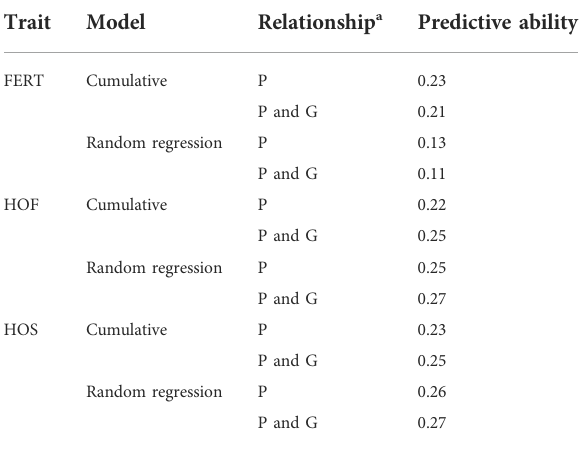
TABLE 11 Estimates of predictive ability using cumulative and random regression models with pedigree and genomic information. Trait